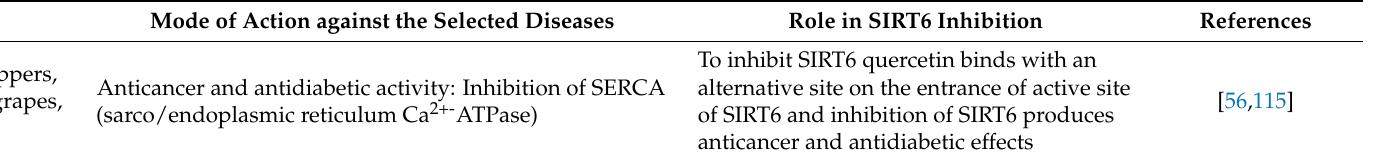
Table 3. Natural products acting as SIRT6